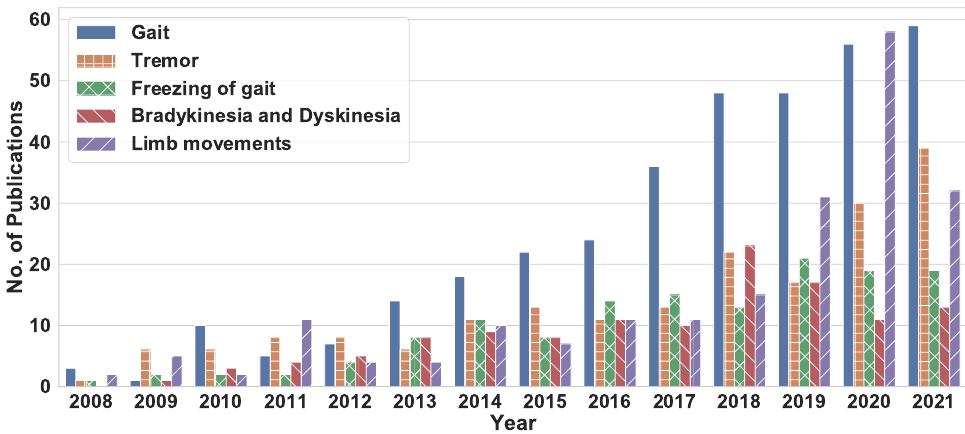
Figure 8. The number of research publications (2008–2021) examining the application of new tech- nologies to specific types of PD symptoms (e.g., FoG, and tremor).